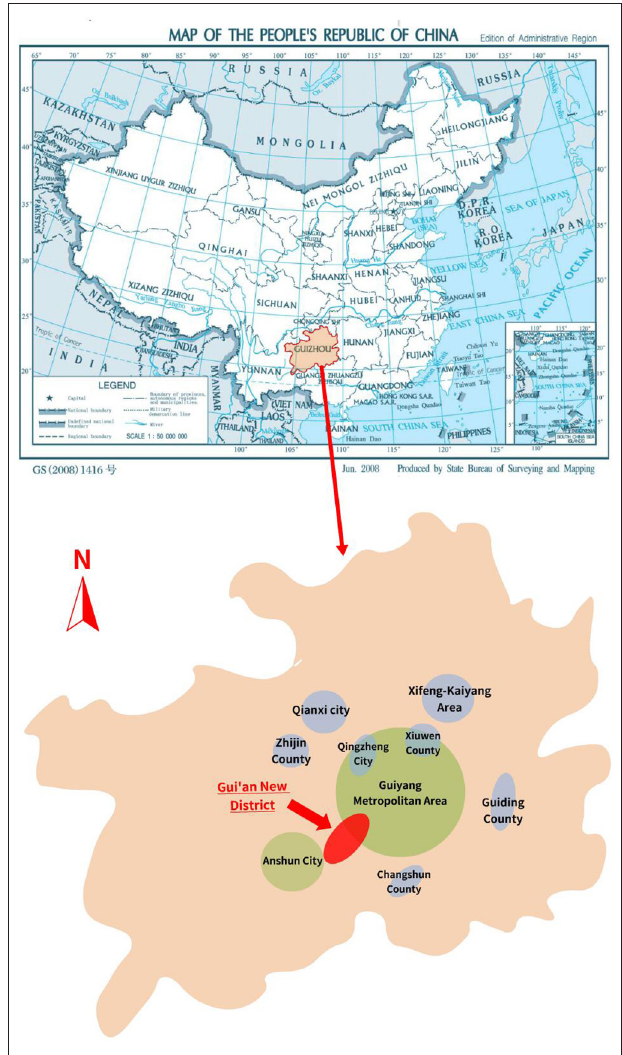
FIGURE 1 | Location of Gui’an New District. (State Bureau of Surveying Mapping, 2008 ), adopted by authors.